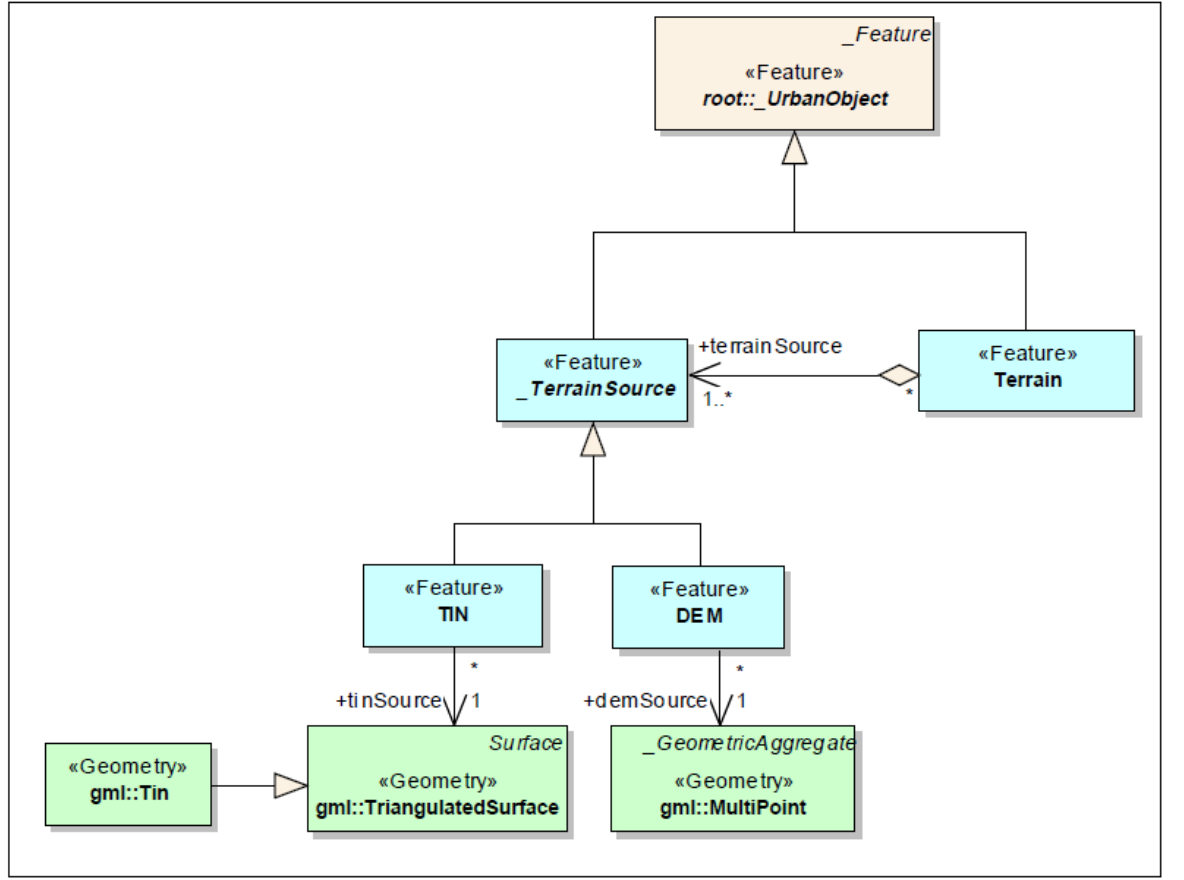
Figure 23. The UML diagram of 3DCDM terrain model.